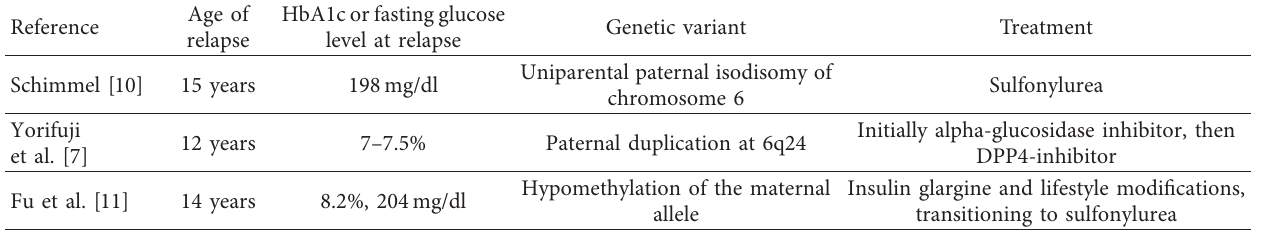
Table 1: Review of the literature of 6q24-related TNDM at